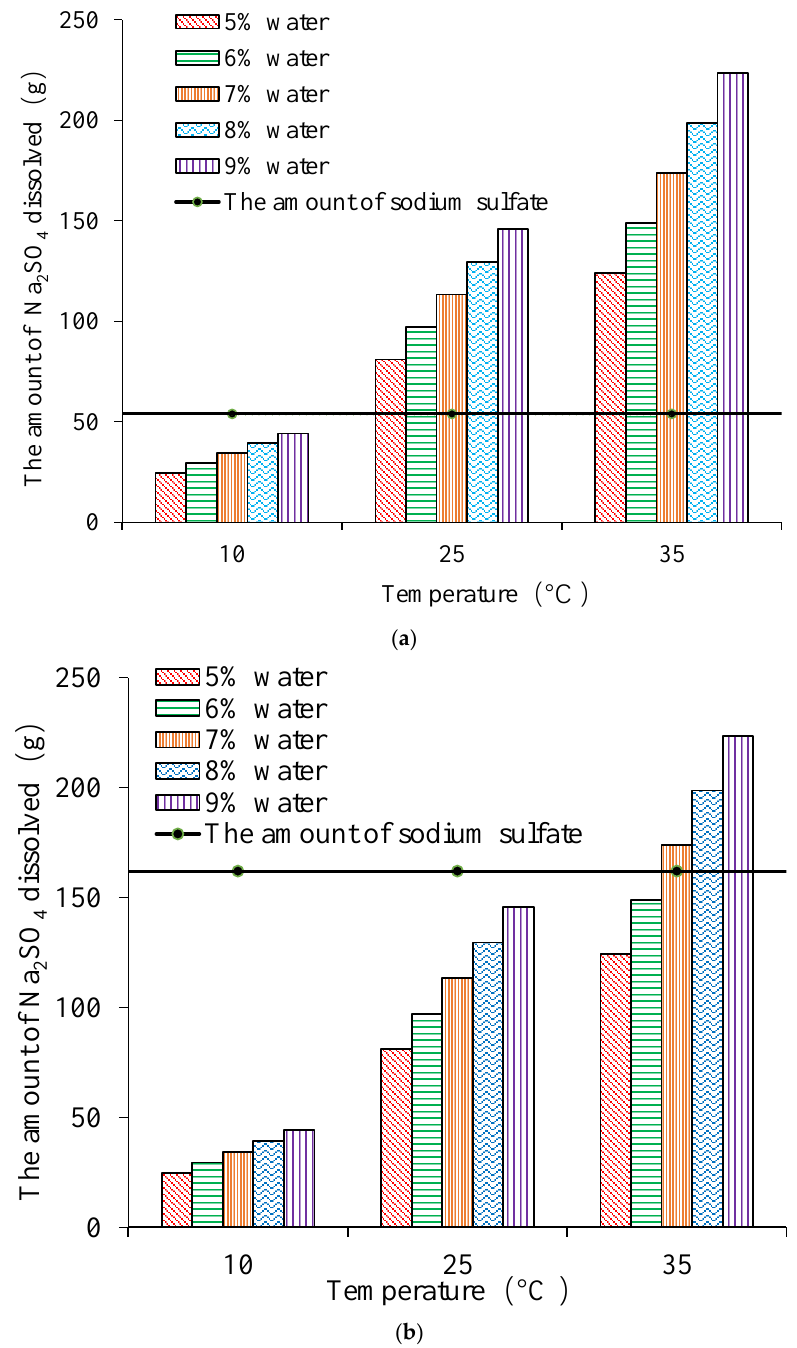
Figure 6. Effect of temperature on the amount of sodium sulfate dissolved in water. ( a ) 1% sodium sulfate. ( b ) 3% sodium sulfate.